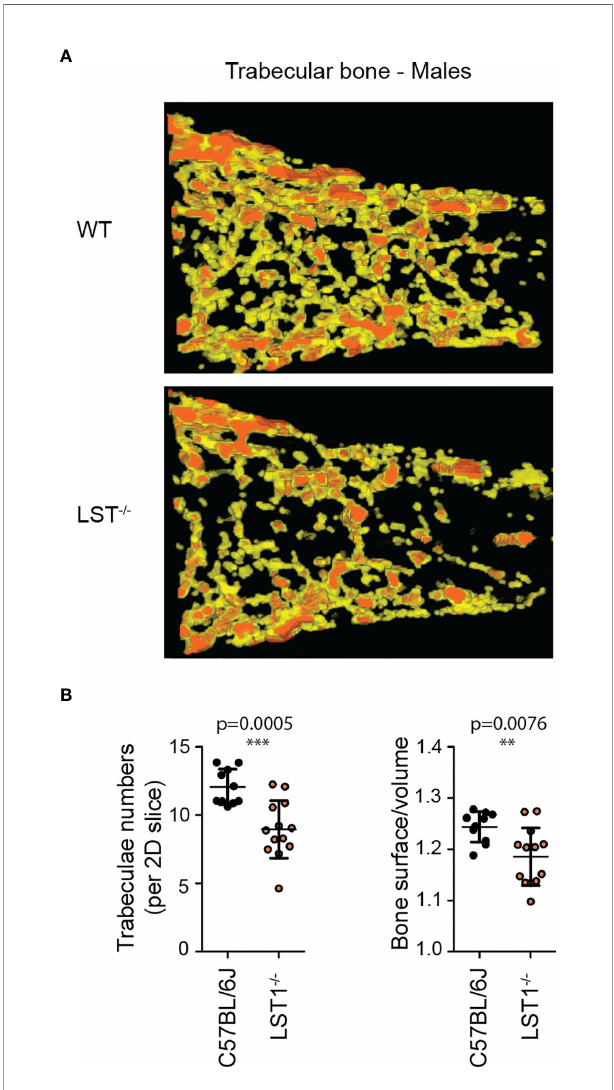
FIGURE 3 | Altered trabecular bone structure in Lst1 -/- mice. (A) Representative picture of trabecular bone µCT scan of male bones with diminished numbers of trabeculae in Lst1 -/- animals (B) Quanti fi cation of trabeculae numbers in 2D plane and ratio between trabecular bone surface and bone volume of WT (n=10) and Lst1 -/- (n=13) mice. Lowered ratio is an evidence of reduced trabeculae segmentation. Dots in scatter plots represent biological replicates (hind limbs, i.e. two dots per mouse). Statistics evaluation was done by Student´s t-test (two-tailed, unpaired) and two-sided Grubb´s test. **p ≤ 0.01, ***p ≤